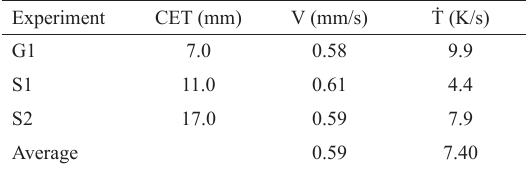
Table 1: CET positions and solidification thermal parameters for the tested directionally solidified cast iron conditions.